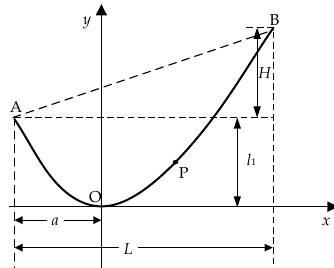
Figure 3. Model of an unequal-altitude catenary.